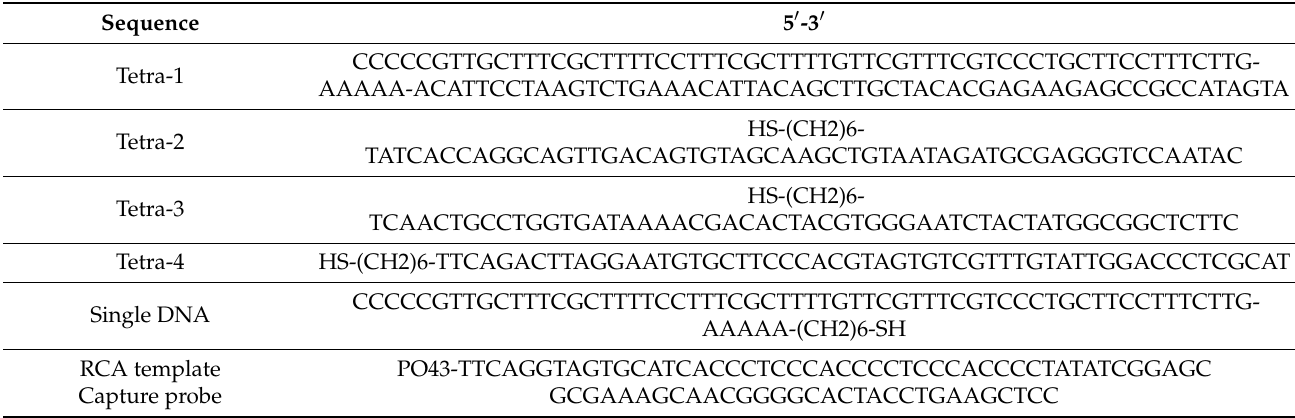
Table 1. The sequences for this